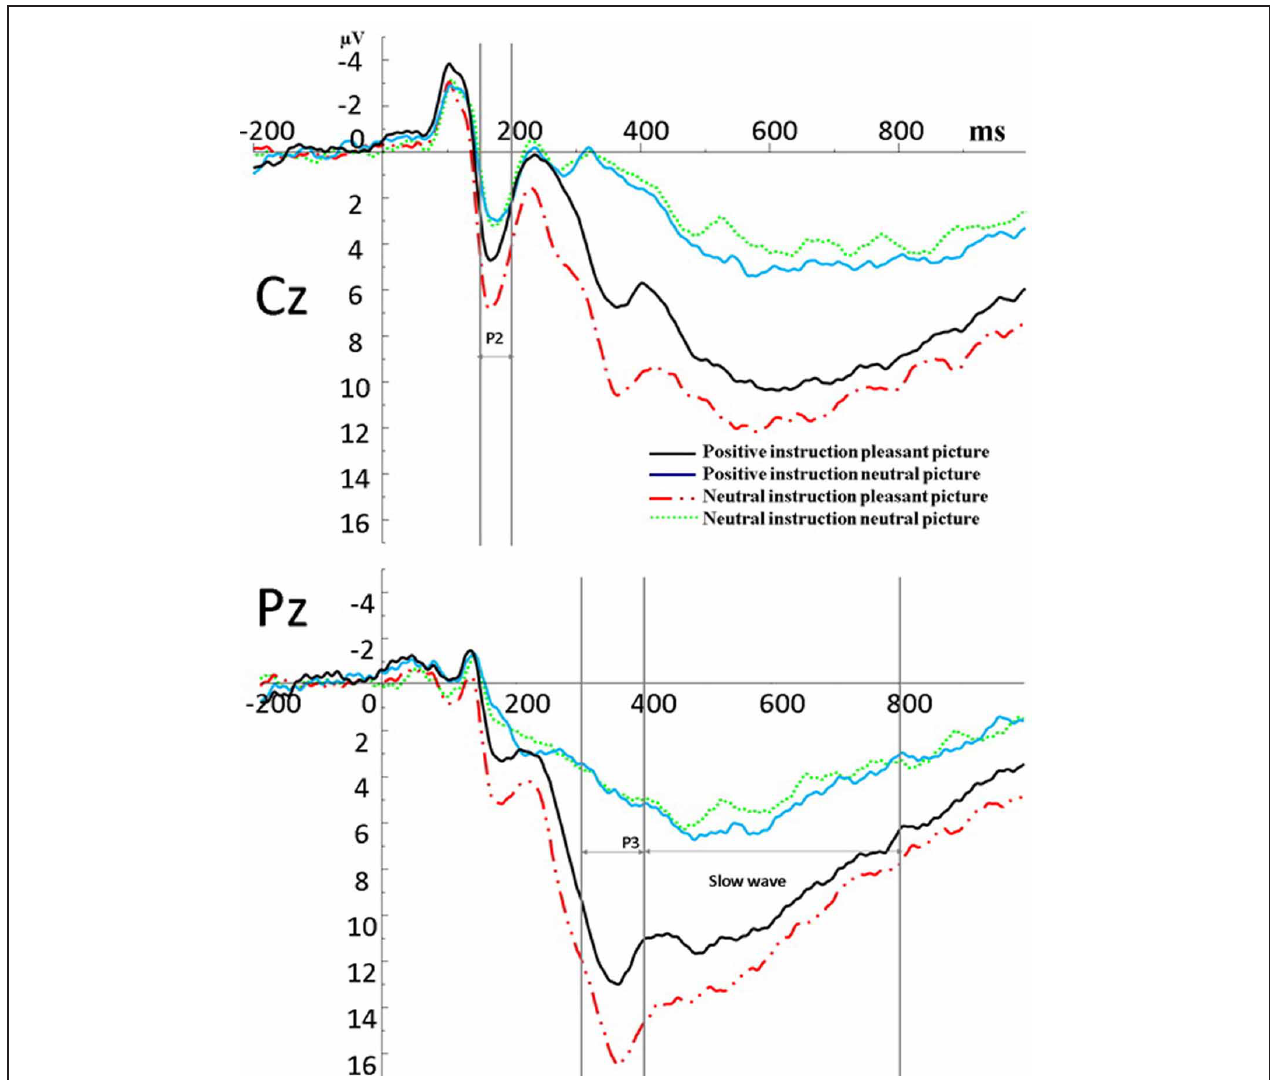
FIGURE 3 | Stimulus-locked ERPs at Cz and Pz for the four conditions. The vertical lines at Cz indicate the time windows (150–200 ms) submitted to statistical analysis of the P2 component.